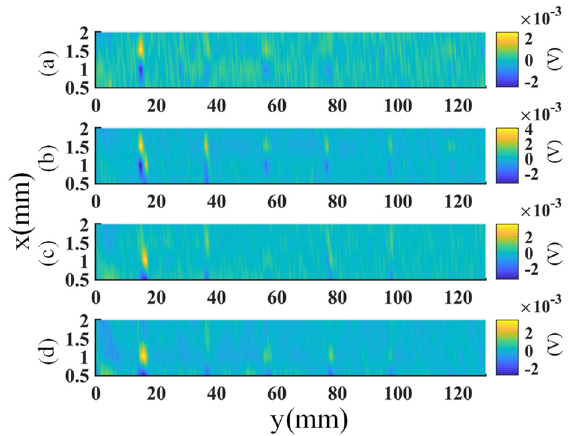
Figure 8. The raw images generated by the four rows of coils with SD excitation: ( a − d ) are the in-phase components of the outputs of the first row to the last row of coils, respectively.